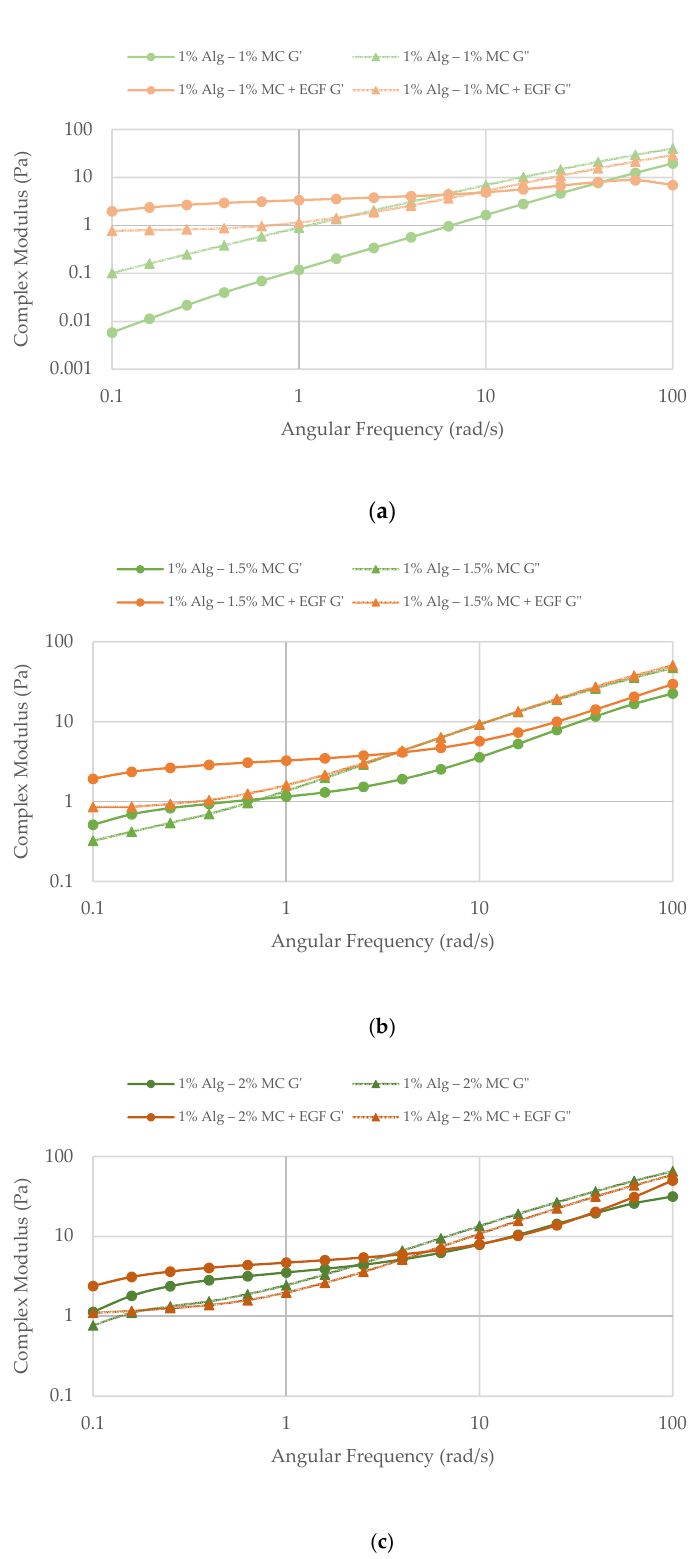
Figure 6. The impact of 3.33 mg/mL epidermal growth factor addition (red) on the viscoelastic moduli G’ ( • ) and G” ( (cid:78) ) of various alginate-methylcellulose mixtures (green) with increasing methylcellulose concentration ( w/v ): ( a ) 1% alginate–1% methylcellulose; ( b ) 1% alginate–1.5% methylcellulose; ( c ) 1% alginate–2% methylcellulose. The circular and triangular symbols appearing in the plots represent the mean-values of discrete measurements evenly acquired at logarithmic intervals under steady-state conditions, while the continuous lines are guides for the